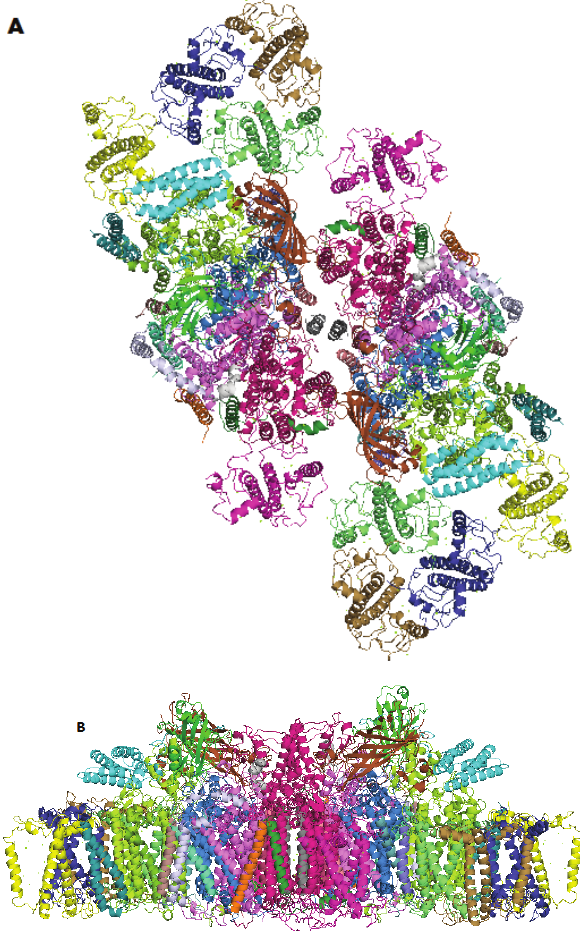
Figure 1: Cryo-electron microscopic structure of PSII-LHCII supercomplex from spinach 3.2 Å resolution. Panel A shows top view of homodimeric PSII-LHCII supercomplex while Panel B shows perpendicular to the membrane. The figure was made in PyMol taking PDB ID of 3JCU